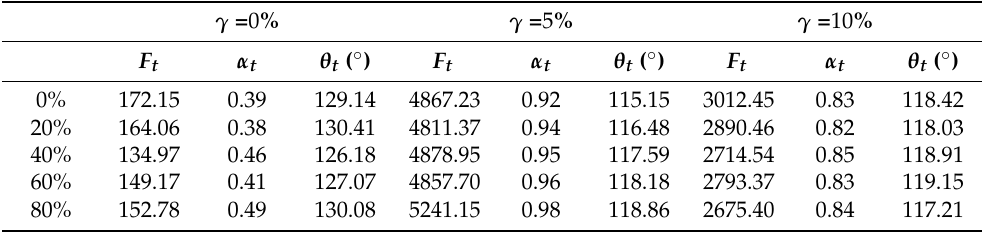
Table 4. Parameters of the shear contact force anisotropy of samples with different RCA